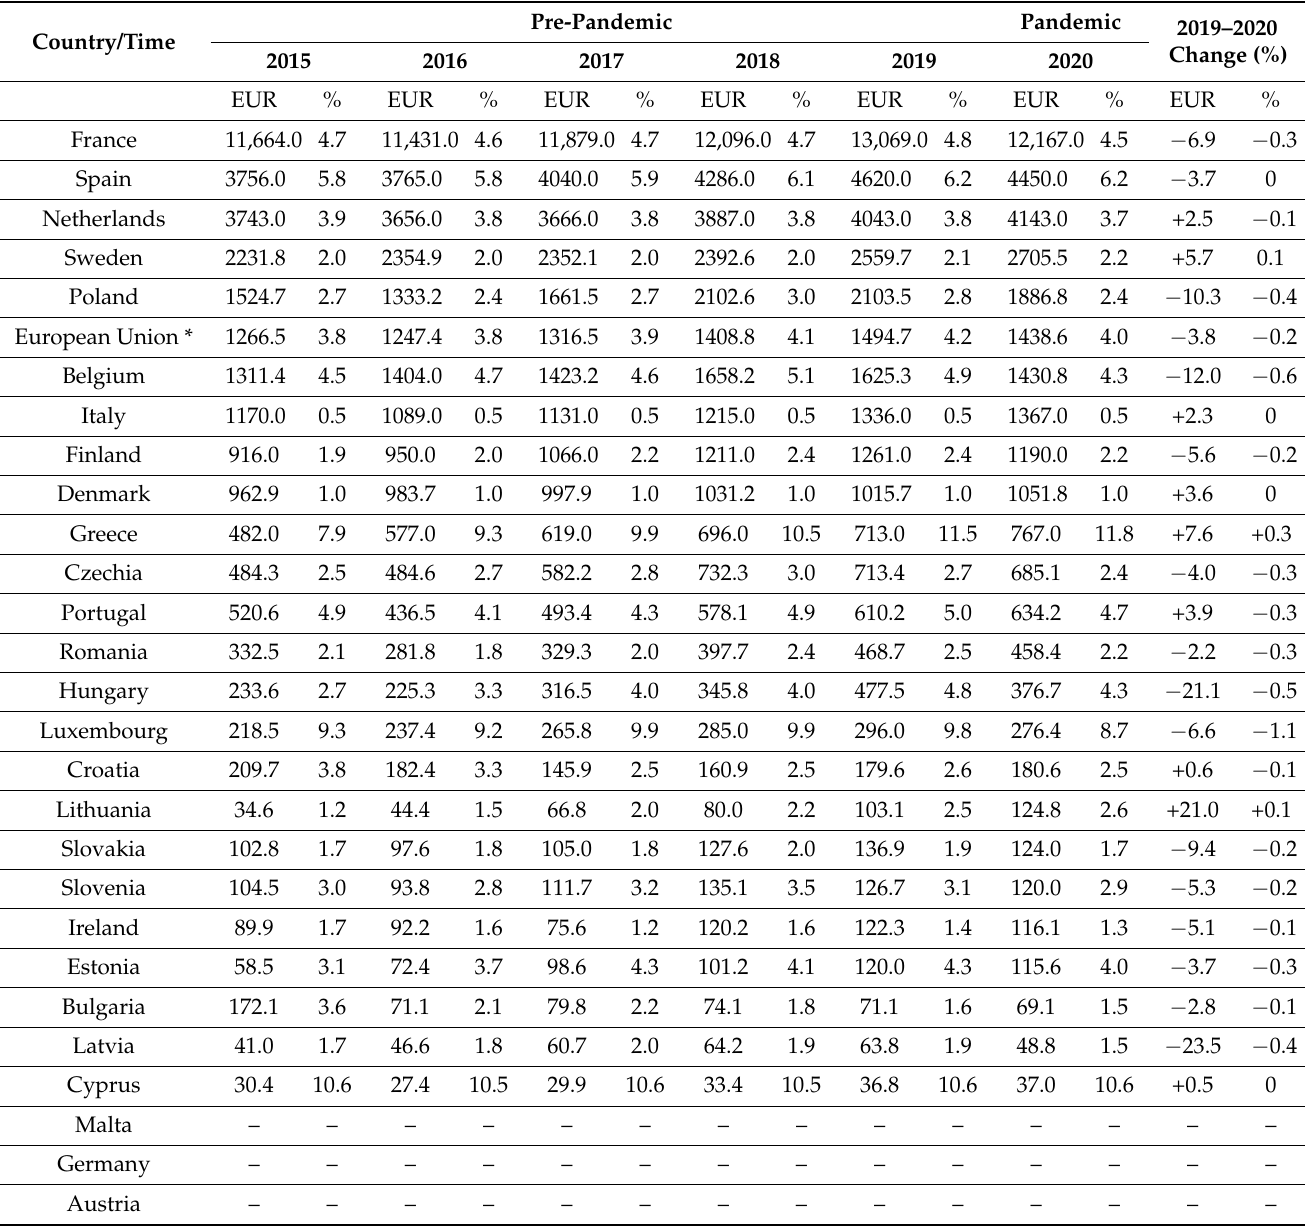
Table 1. Local government expenditure on recreational and sporting services in European Union countries (in million euros and as the percentage of the